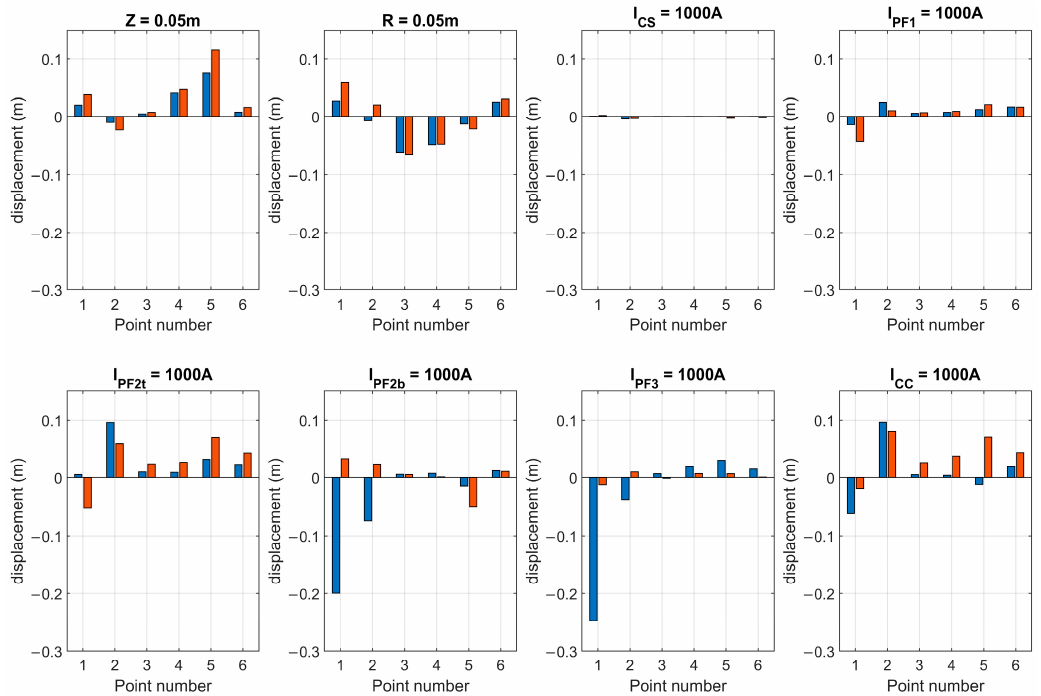
Figure 11. Sensitivity of plasma shapes, namely, gaps, to the references of the plasma position and the currents in the PF-coils for shot #37239 of tokamak Globus-M2 versus shot #31648 of Globus-M at 185 ms. Histograms show a strong connection between plasma position and plasma shape, a weak influence from the central solenoid current on the plasma shape, and a strong cross-influence from the PF-coils currents on the plasma shape’s projections, P1–P6.